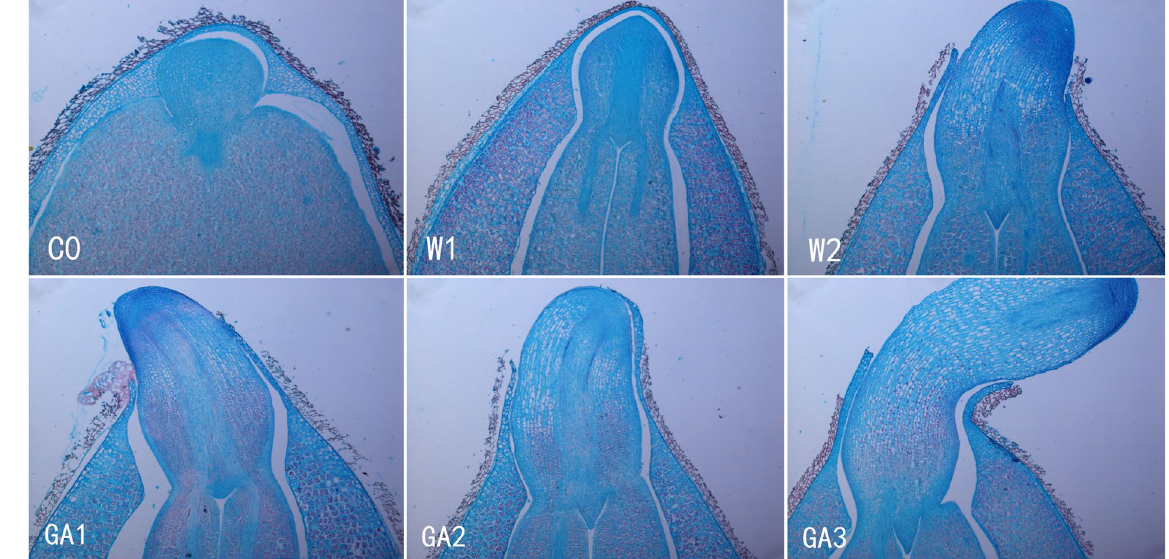
Figure 1. The morphology during the early stage of germination of zanthoxylum